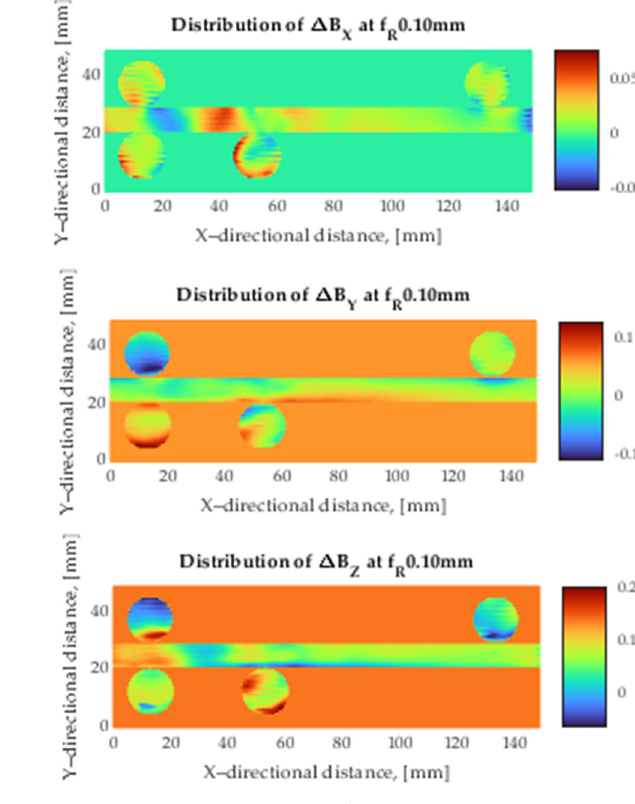
Figure 3. Experimental results: ( a ) distribution of the magnetic flux density, 𝐵 (cid:3025) , 𝐵 (cid:3026) , and 𝐵 (cid:3027) ; ( b ) distribution of the subtract magnetic flux density, Δ𝐵 (cid:3025) , Δ𝐵 (cid:3026) , and Δ𝐵 (cid:3027) .